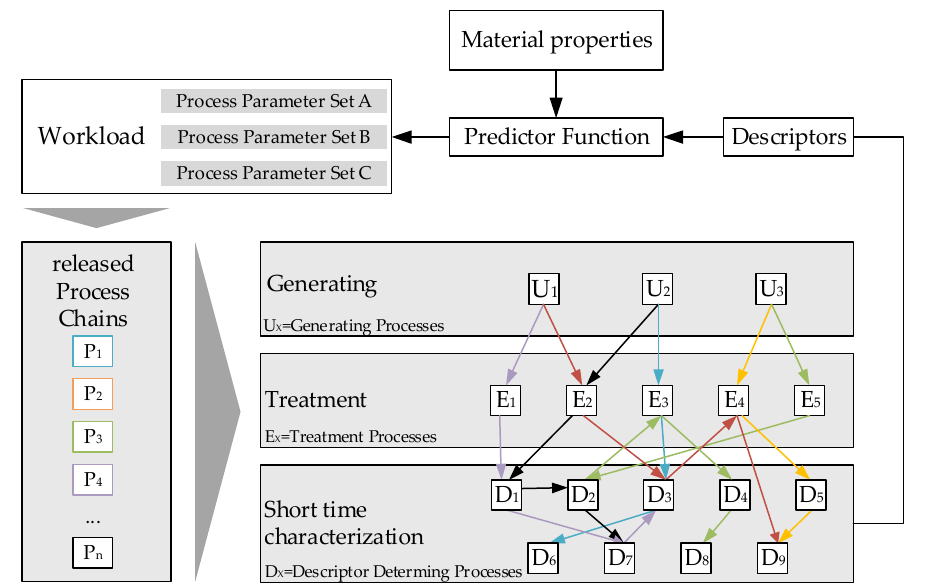
Figure 1. Procedure of the method ‘Farbige Zustände’.